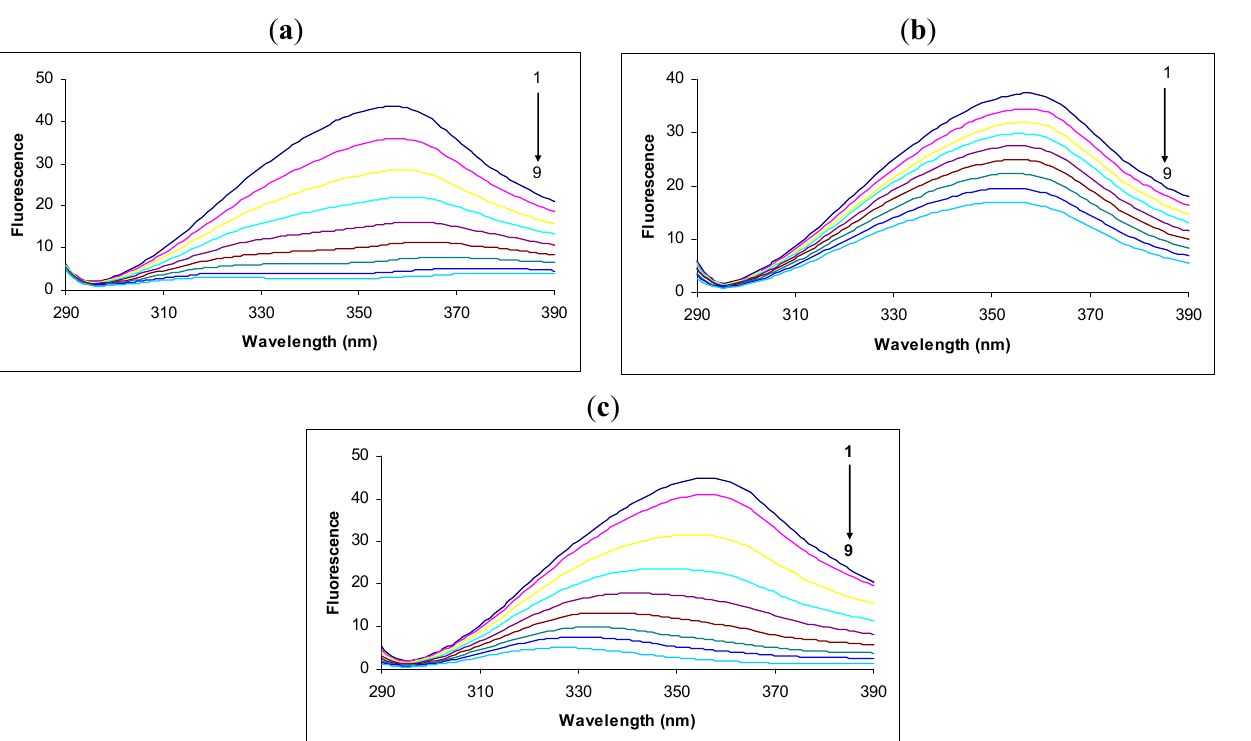
Figure 1. Fluorescence spectra of tryptophan (1.0 g/mL) in the absence (black, spectrum 1) or presence of: ( a ) 2.4-DNP (6.65 × 10 − 6 ; 10 × 10 − 6 ; 13.33 × 10 − 6 ; 16.66 × 10 − 6 ; 20.00 × 10 − 6 ; 23.33 × 10 − 6 ; 26.66 × 10 − 6 ; 30.00 × 10 − 6 M, respectively, spectra 2-9); ( b ) 2.6-DNP (6.65 × 10 − 6 ; 10 × 10 − 6 ; 13.33 × 10 − 6 ; 16.66 × 10 − 6 ; 20.00 × 10 − 6